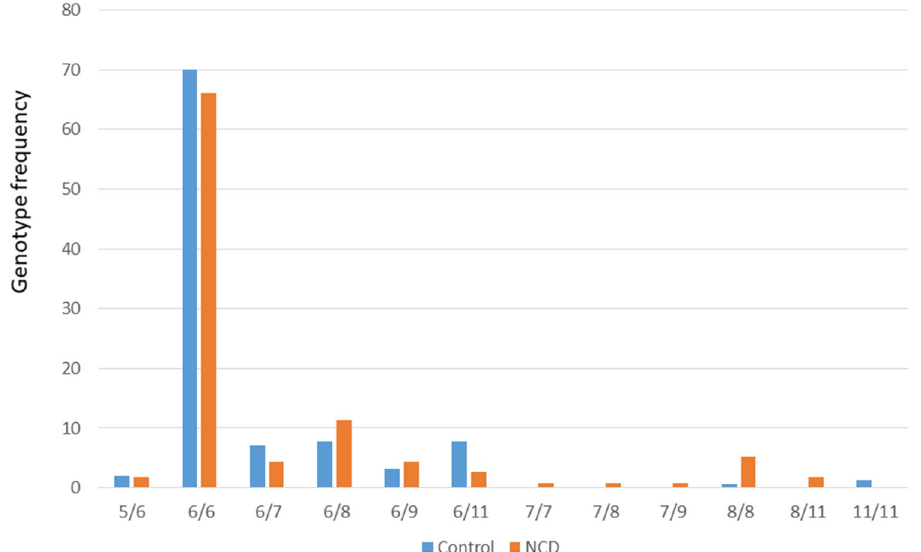
Figure 3. Genotype frequency of the RASGEF1C (GGC)-repeat in NCD patients and controls. While the 6/6 genotype was the predominant genotype in both groups, excess of divergent genotypes was detected in the NCD